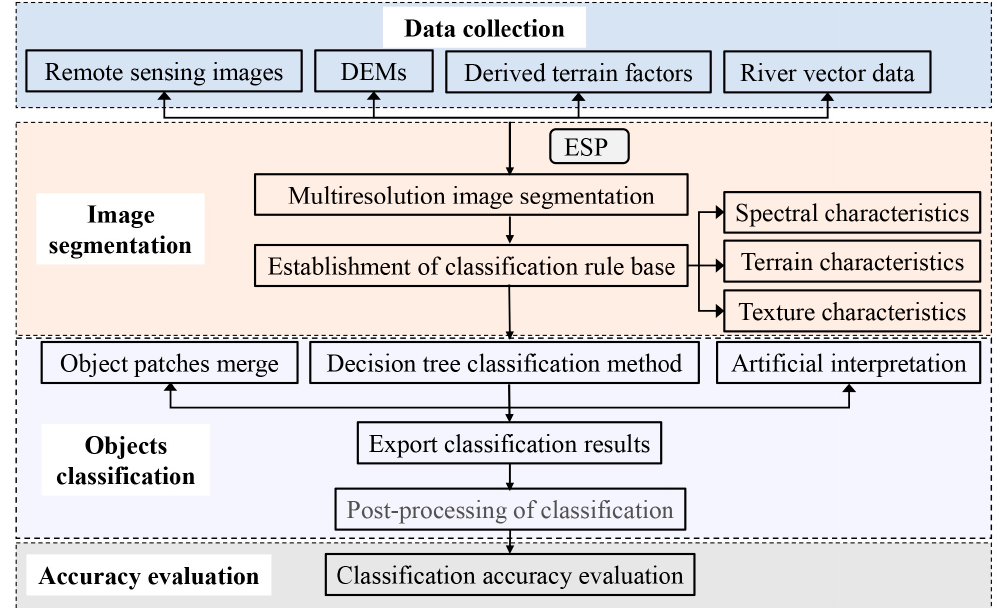
Figure 2. Flow chart of the loess landform classification process. According to the formula, the factors influencing the multiresolution segmentation effect in eCognition software include the weight of different bands, the segmentation scale parameter, shape weight, and compactness weight. When applying MRS, considering the strong control effect of the terrain factor on the segmentation process, the weight of the terrain feature is set to 2, whereas the weight of the spectral feature is set to 1. The